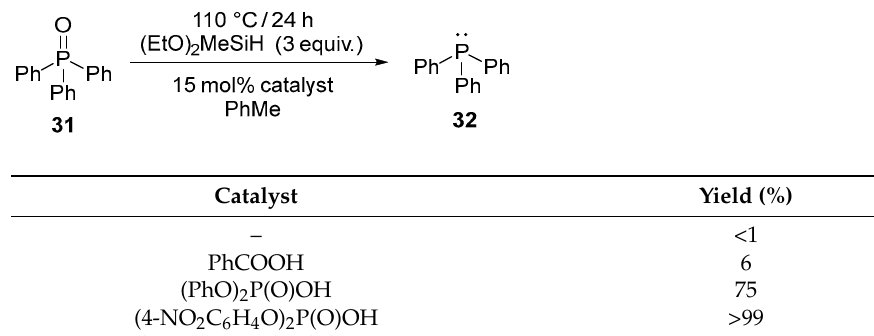
Table 8. Deoxygenation of triphenylphosphine oxide ( 31 ) using (EtO) 2 MeSiH with acid catalysts.